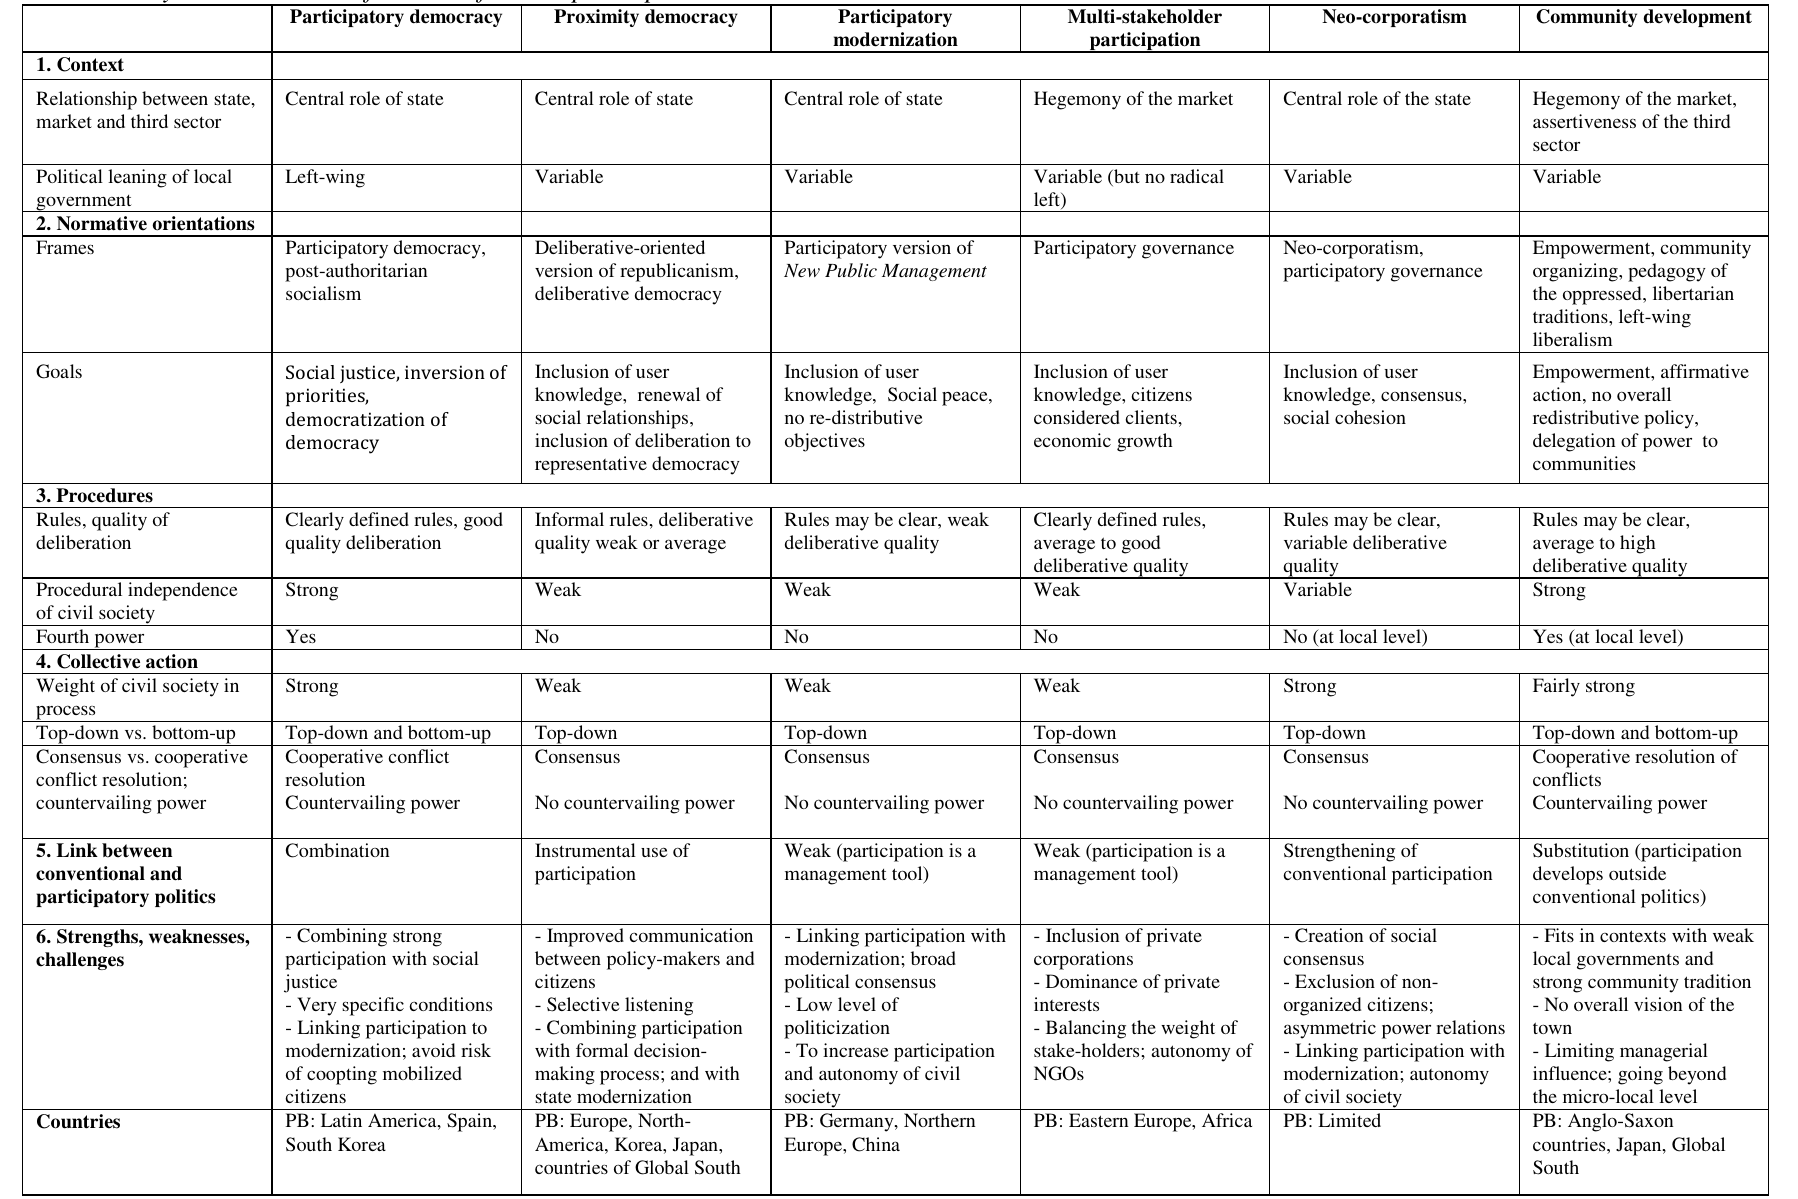
Table 2. Key characteristics of models of citizen